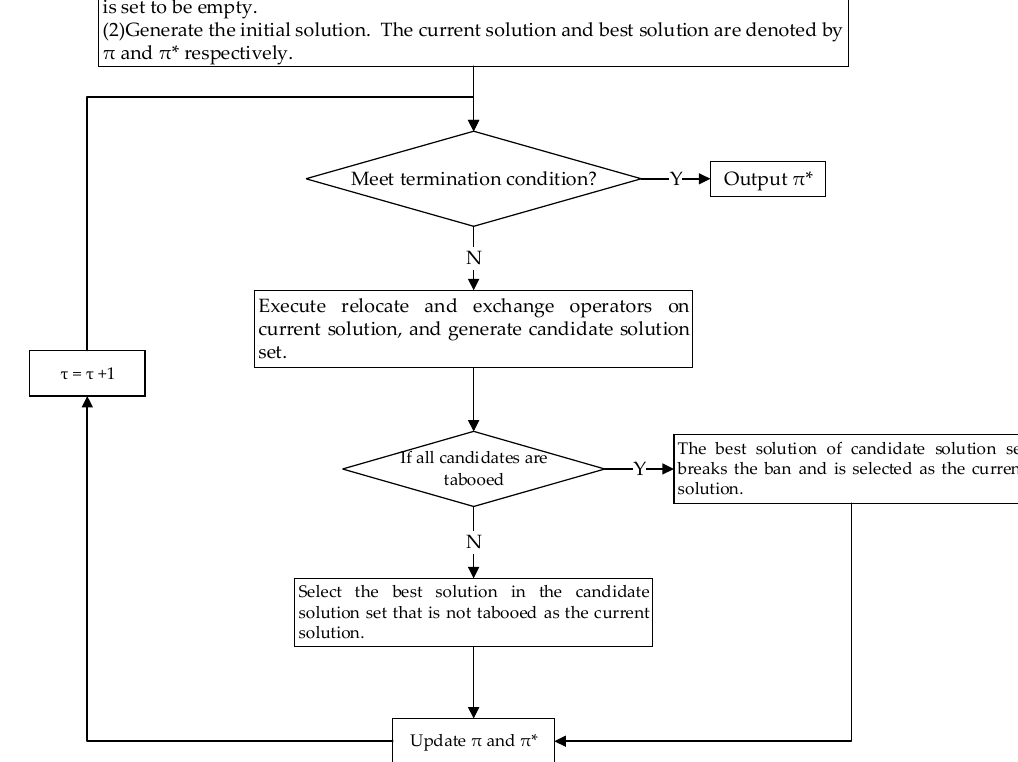
Figure 9. Novel tabu search (NTS) algorithm flowchart.